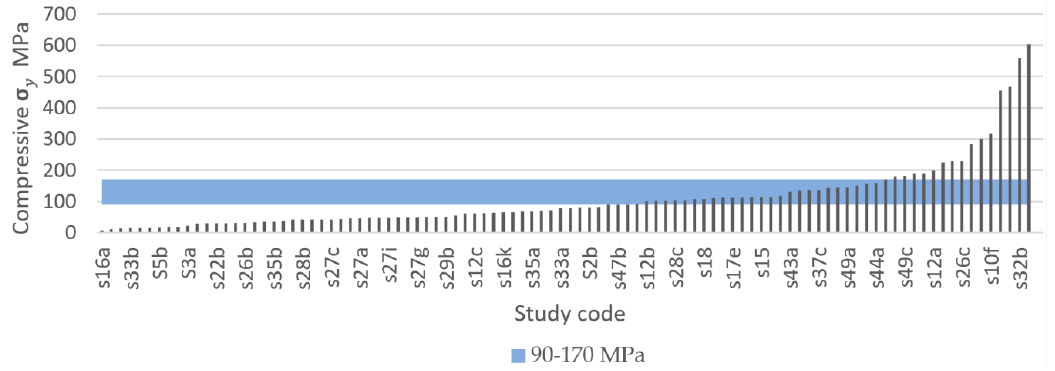
Figure 15. Compressive yield strength of porous beam-based metamaterials compared with the Ideal Quality Attribute (IQA) target zone.